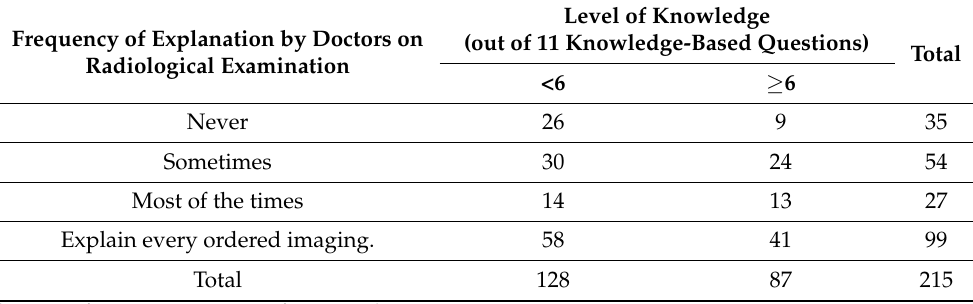
Table 5. The number of respondents who achieved satisfactory scores and the frequency of explana- tion regarding radiological examinations that their children underwent. Ninety-nine respondents agree that doctors would explain every medical imaging ordered for their children. There is no association between frequency of explanation and level of knowledge level on the subject matter. Level of Knowledge Frequency of Explanation by Doctors on (out of 11 Knowledge-Based Questions) Total Radiological Examination <6 ≥ 6 Never 26 9 35 Sometimes 30 24 54 Most of the times 14 13 27 Explain every ordered imaging. 58 41 99 Total 128 87